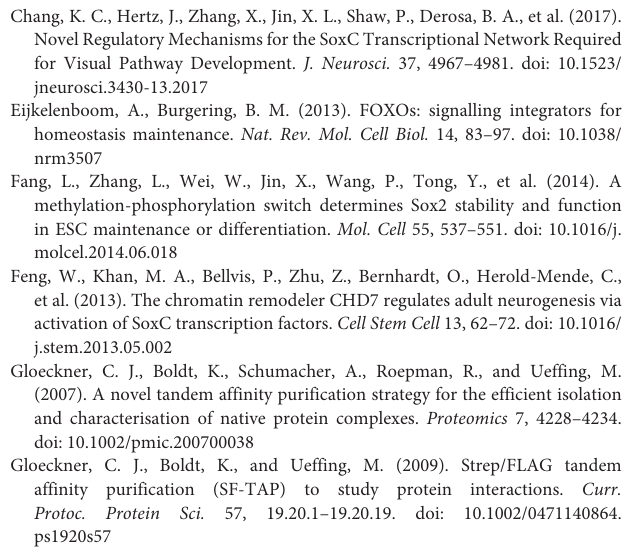
FIGURE S4 | Full blots from Figure 6F . (A) Blotting against SOX11, pRNApolymerase II as a nuclear marker, and against α Tubulin as a cytoplasmic marker. (B) Blotting against pCREB as a nuclear marker. TABLE S1 | The table summarizes the mass spectrometric analysis. The peptide report (filtered for Sox11 phospho peptides) of Proteome Discoverer is provided. In addition to the standard information (including the confidence level and identification scores), it also reports site-probability sores for the observed phosphorylation determined by the Proteome Discoverer Module PhosphoRS. In addition, the cell type (HEK293T or Neuro2a) and fraction (nuclear/NE or cytosolic/CE) are provided for each peptide. Two individual sets of experimental data from two different mass spectrometers (fragmentation and detection methods) are shown: FVZ1262 (ITMS/Orbitrap Fusion, CID fragmentation/linear ion trap detection) and FVZ2070 (FTMS/Q-Exactive Plus, HCD